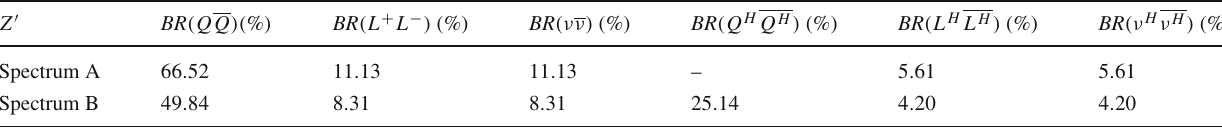
Here Q denotes 6 quark flavors ( u , d , c , s , t , b ) and L ( ν ) represents 3 lepton flavors ( e (ν e ),μ (ν μ ),τ (ν τ ) ) Table 3 Branching ratios for different decay modes of W (cid:2) ( p , m )